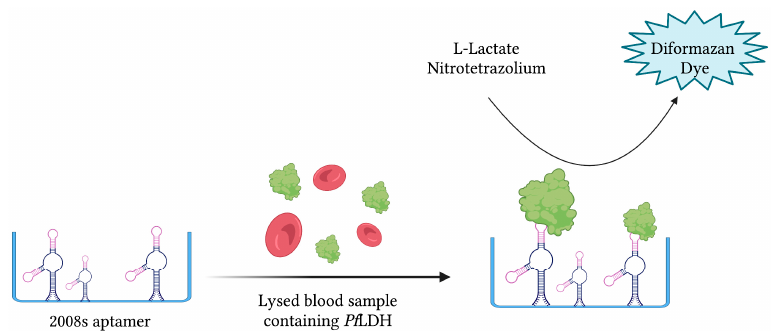
Figure 8. The schematic illustration of the colorimetric-based aptasensor for Plasmodium falciparum LDH detection described by Dirkzwager et al. [44]. Pf LDH is captured and immobilized by 2008s aptamers. A Pf LDH-mediated catalytic reaction yields a detectable color change proportional to its concentration. Adapted with permission from Ref. [44]. 2016, American Chemical Society. Created with BioRender.com (accessed on 19 December 2021).